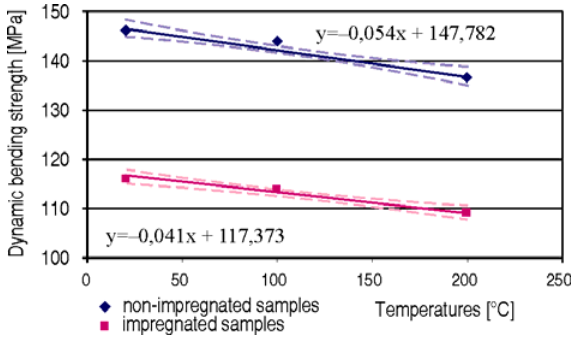
Fig 10. Dynamic bending strength vs. temperature for impregnated and non-impregnated wood